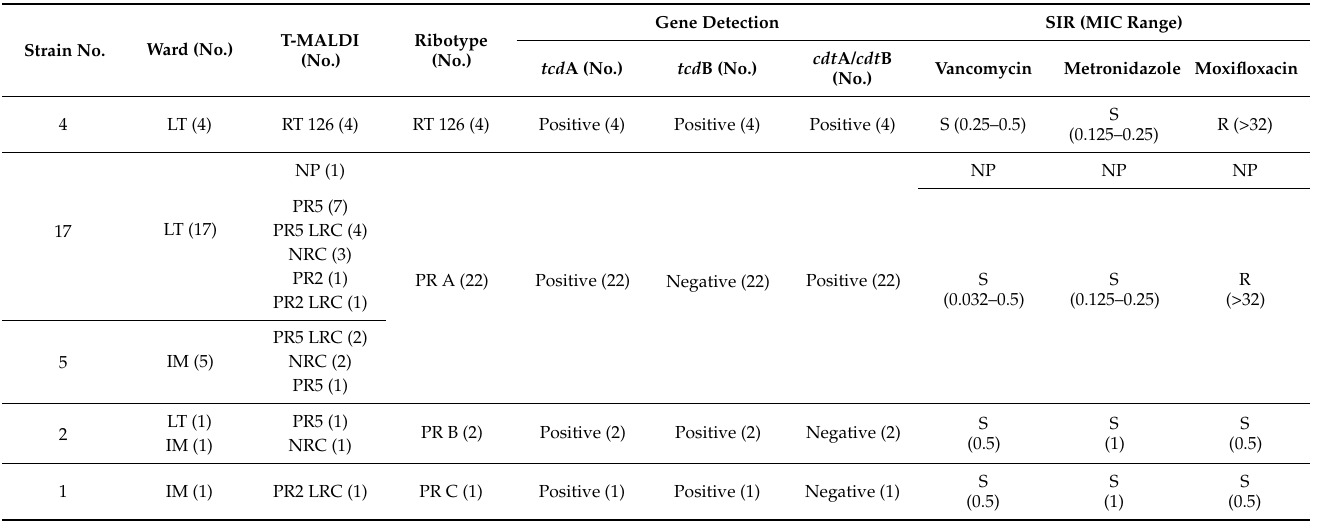
Figure 3. Different DNA amplification patterns obtained by PCR-Ribotyping. Line 1, Ribotype 126; Lines 2–4 and 8–13, ribotype PRA; Line 5, ribotype PRB; Line 6, rRibotype PRC; Line 15, Ribotype 127, Line 16, Ribotype 018; Line 17, Ribotype 126; Lines 7, 14, and 18, 100 bp DNA Molecular Weight Marker VIII. Table 2. Characterization of the 29 C. difficile isolates.